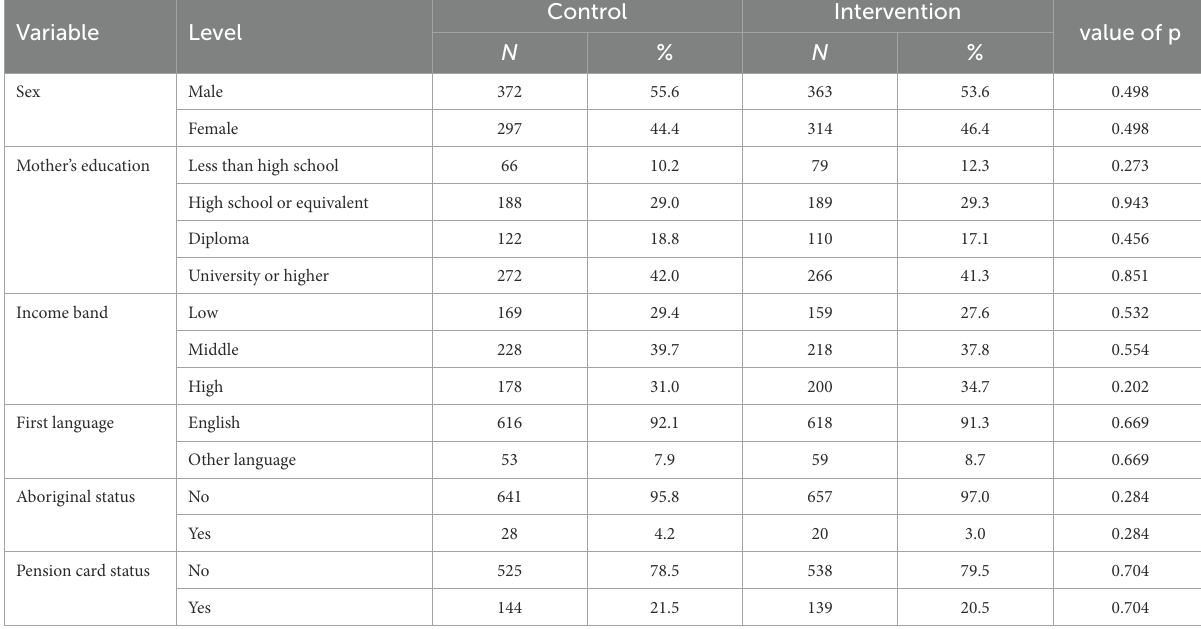
TABLE 2 Child characteristics in intervention/control group.